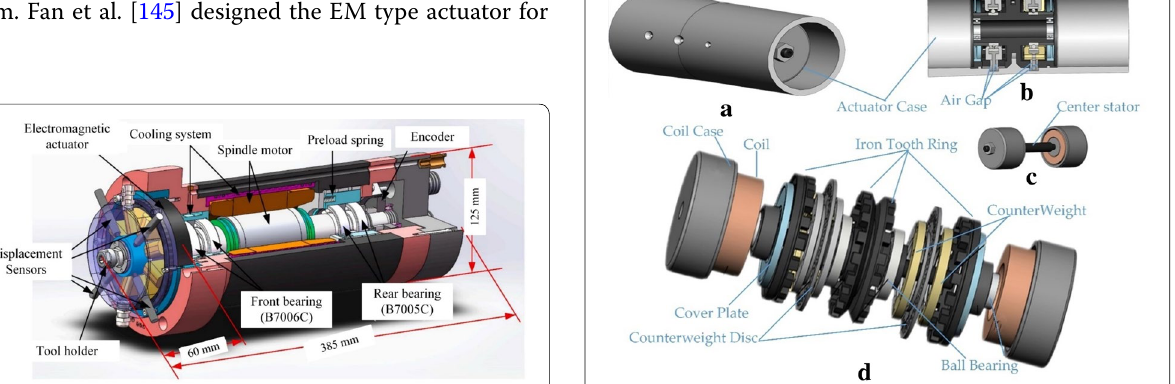
Figure 37 Spindle system with electromagnetic actuator